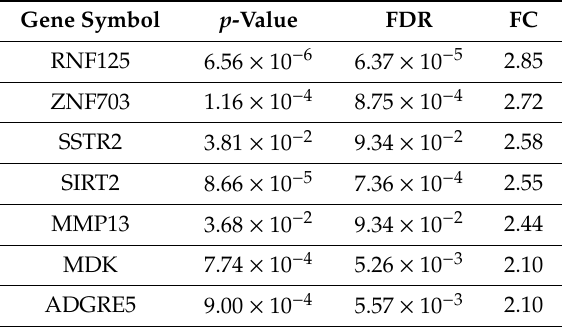
Table 4. DEGs emerged in A2780 cells after 48 h co-culture with A2-derived ML-Ddx4 +